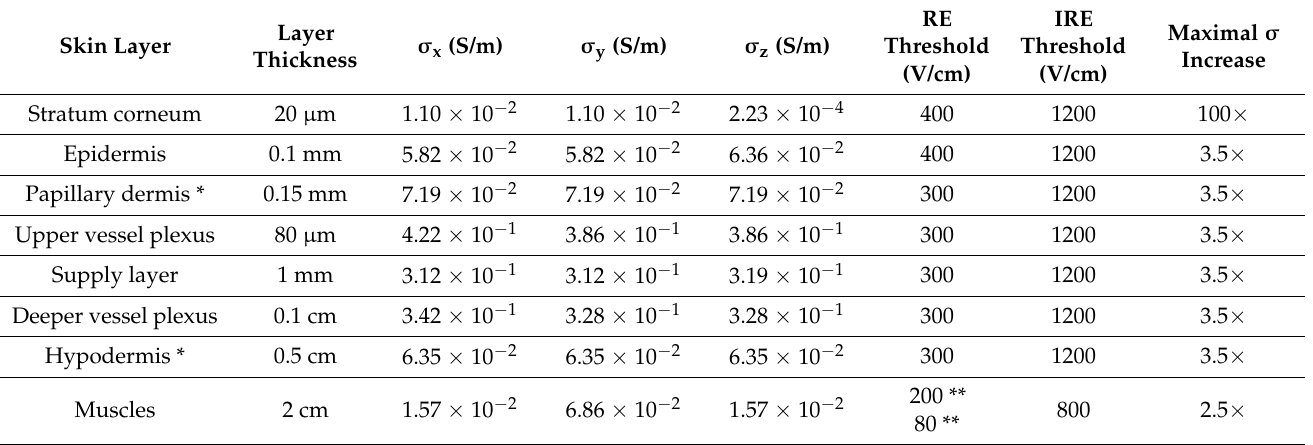
Table 1. Properties of each skin layer used in the numerical model. σ signifies the electrical conduc- tivity; RE—reversible electroporation; IRE—irreversible electroporation.